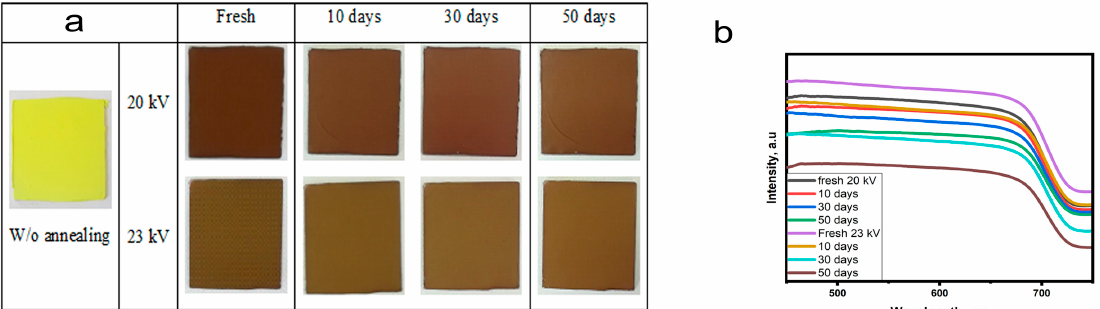
Figure 9. ( a ) Photos of fresh, 10-day, 30-day, and 50-day samples, fabricated at electrical voltage values 20 kV and 23 kV; ( b ) light absorption spectra of fresh, 10-day, 30-day, and 50-day samples, fabricated at electrical voltage values 20 kV and 23 kV. Samples were made according to the following parameters: voltage: 20 and 23 kV, distance: 150 mm, needle diameter: 0.42 mm, feed rate: 0.1 mL/h, planar collector).